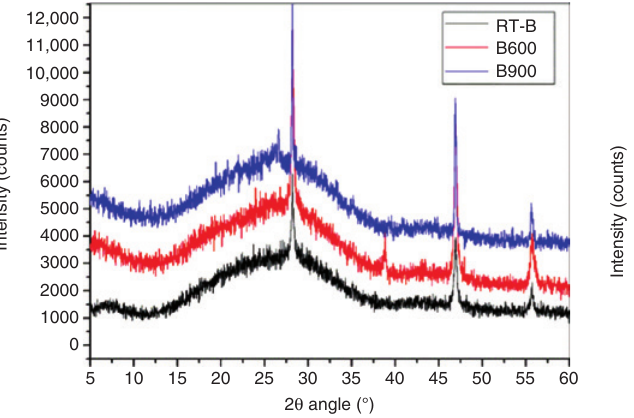
Figure 4: XRD pattern of sample A at room temperature (RT-A), A600 and A900.